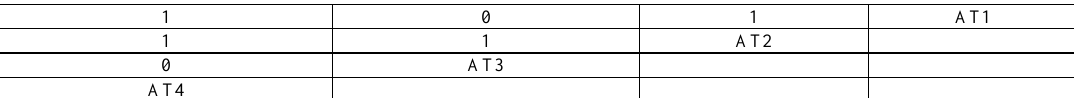
Table 4. Self-interaction binary matrix for actors in binary form.